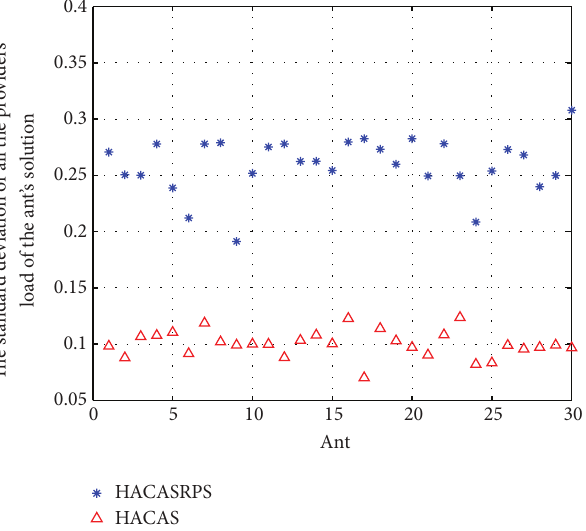
Figure 9: The standard deviation of all the providers’ loads of the ant’s solution in the 5th cycle.